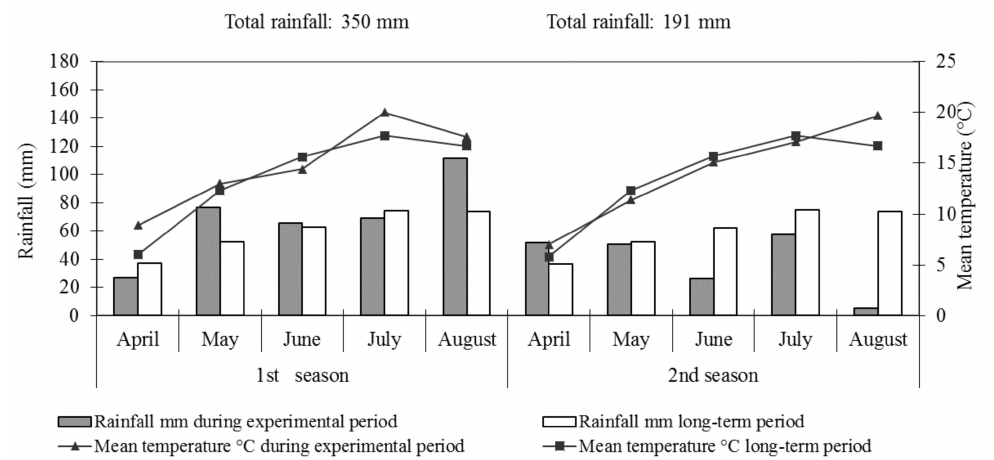
Figure 2. The distribution of rainfall and temperature during the growing